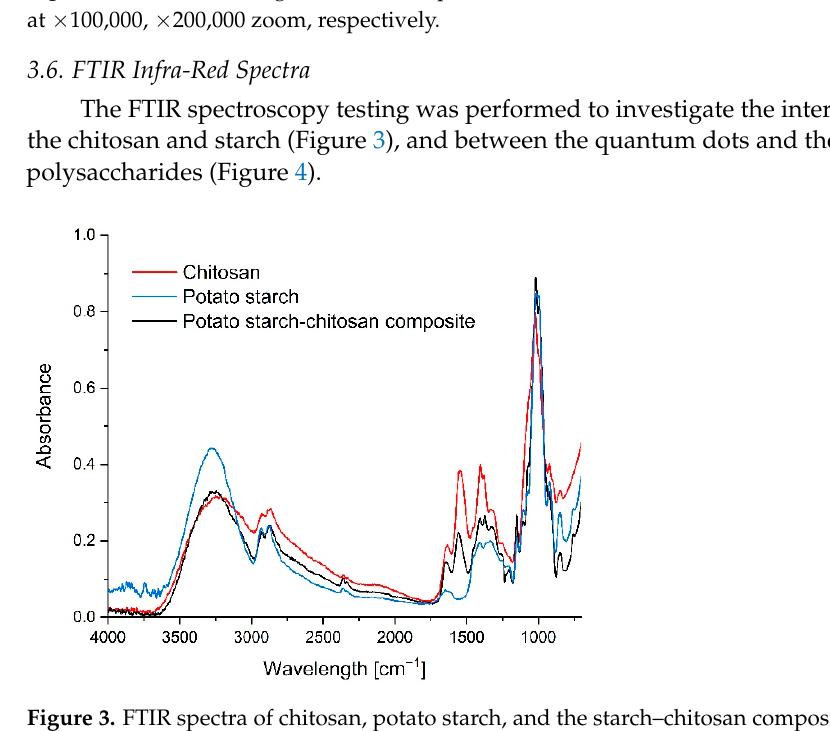
Figure 3. FTIR spectra of chitosan, potato starch, and the starch–chitosan composite.